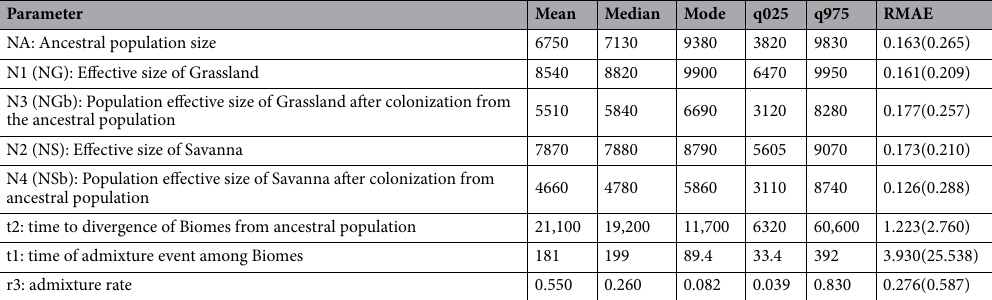
Table 7. Model parameters estimated (mean, median and mode with 95% confidence intervals and RMAE values (relative median of the absolute error)) from posterior distribution of the best evolution scenario